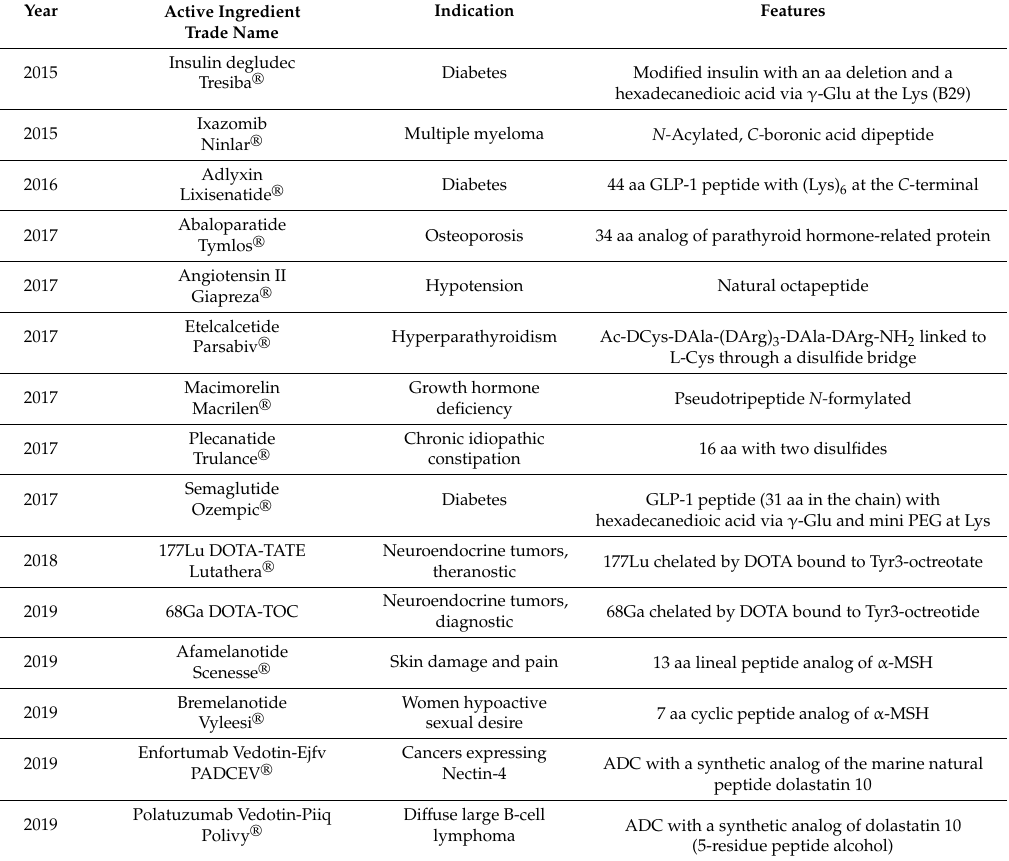
Table 1. Peptide-based drugs approved by the Food Drug Administration (FDA) (2015–2019)